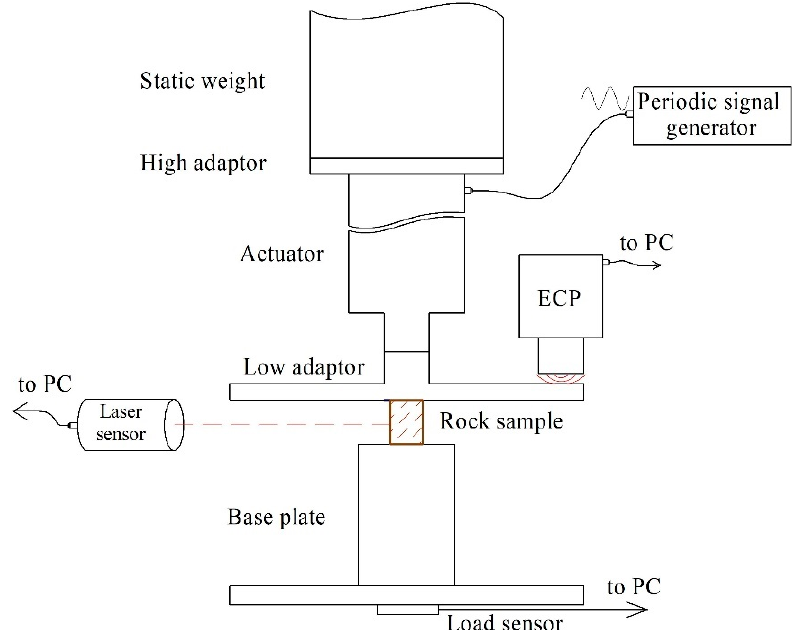
Figure 1. Schematics of the small experimental set-up: a rock sample was loaded with static load and dynamic load produced by an actuator that was powered with a periodic signal from a generator. External load was measured by a load sensor. The sample’s deformation was recorder by a laser sensor and an eddy current probe (ECP).